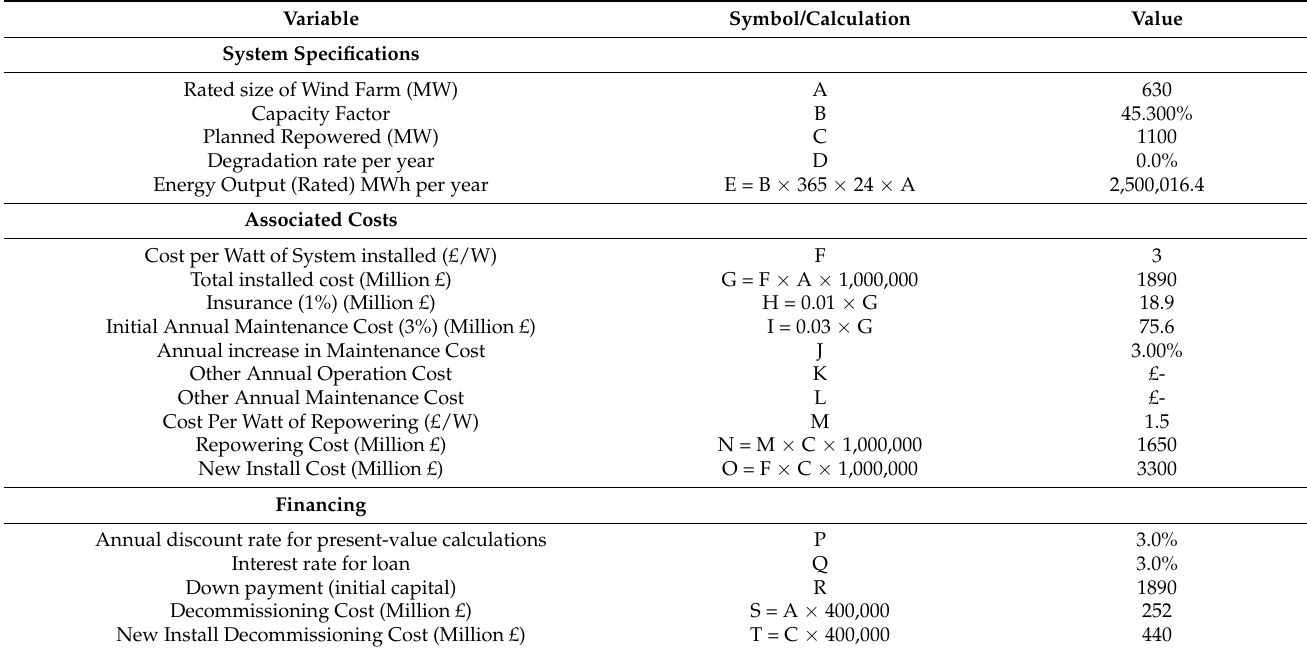
Table 3. Inputs for financial model using London Array.